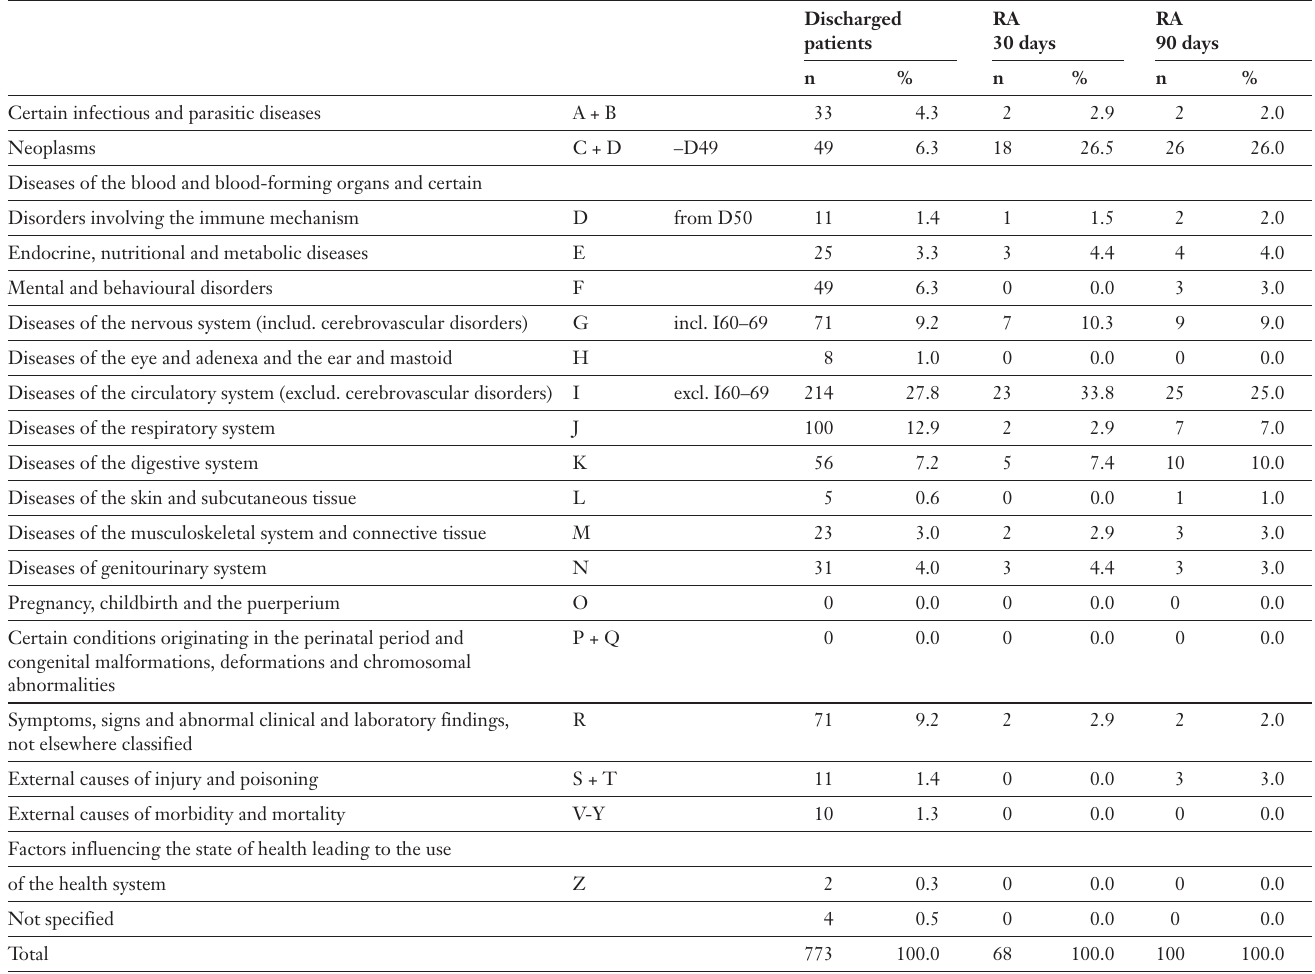
Diagnoses and rate of RA according to ICD-10